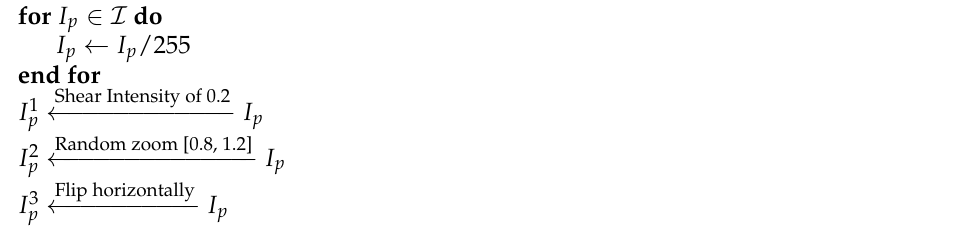
Algorithm 2 Real-time data augmentation and pre-processing on the image data